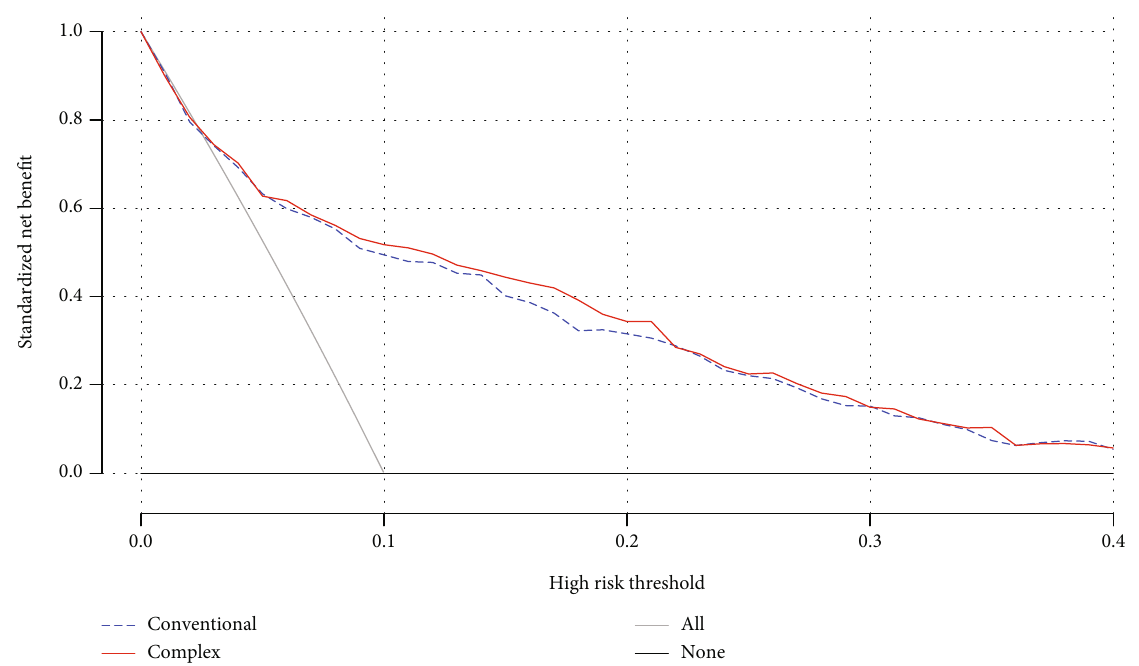
Figure 3: Decision curve analysis of the two prediction models. X -axis indicates the threshold probability for critical care outcome, and Y -axis indicates the net bene fi t. Blueline = conventional model based on age, sex, smoking status, diabetic course, platelets (PLT), red blood cell (RBC), and white blood cell (WBC) and red line = complex model based on age, sex, smoking status, diabetic course, PLT, RBC, WBC, and cystatin